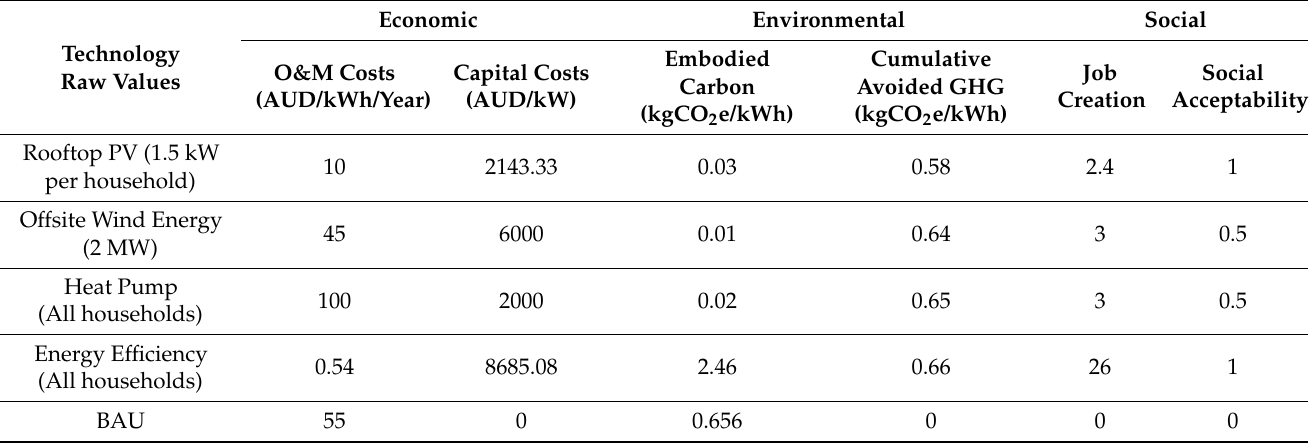
Table 5. The indicator outputs and normalisation.